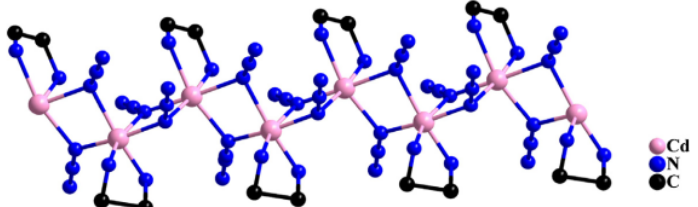
Figure 1. The 1D chain structure along a-axis in [Cd(en) (N 3 ) 2 ] n and octahedral coordination structure of